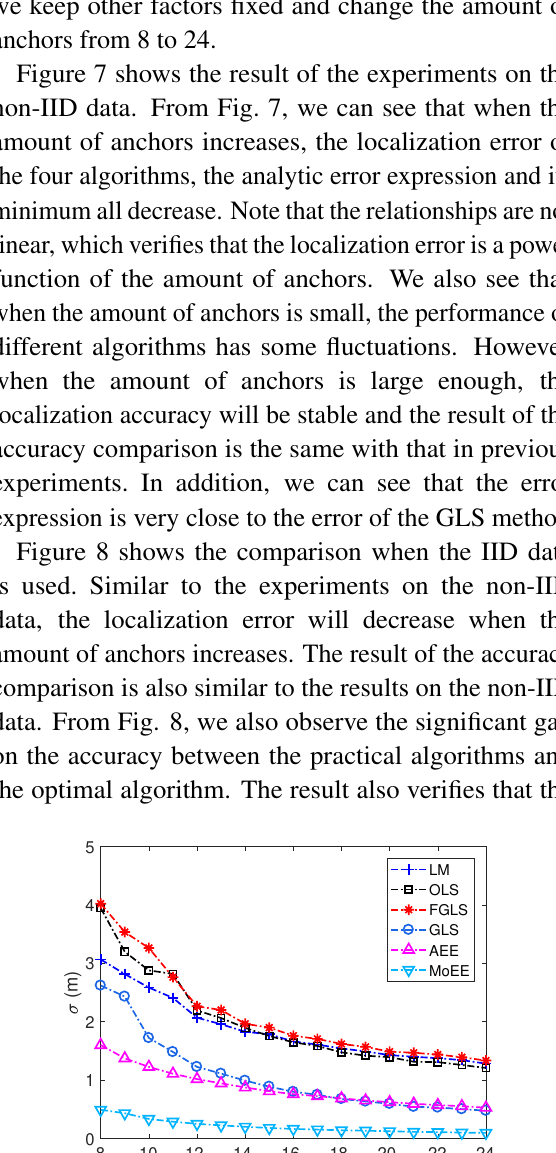
Fig. 8 Effects of the amount of anchors with IID